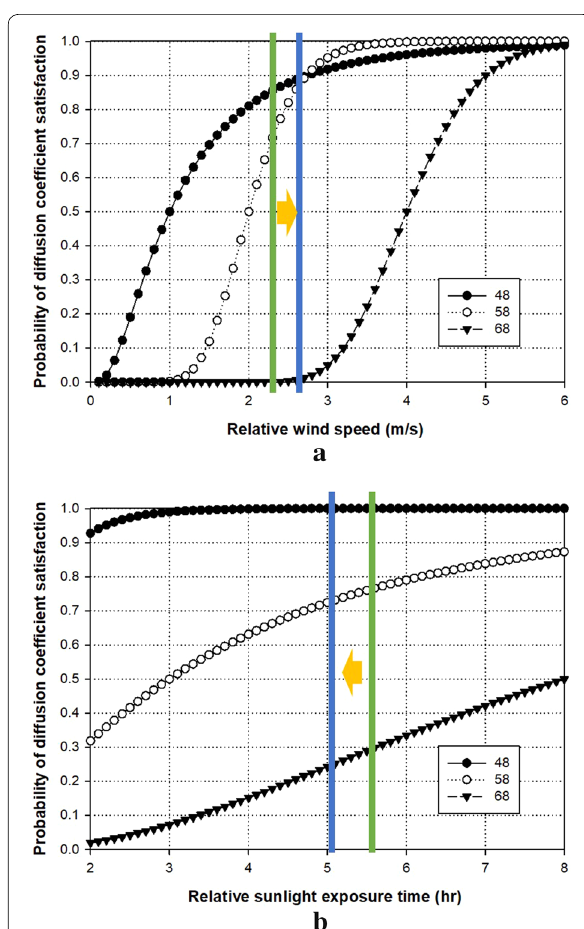
Fig. 14 Application of RCP for climate change scenarios on chloride diffusion coefficient